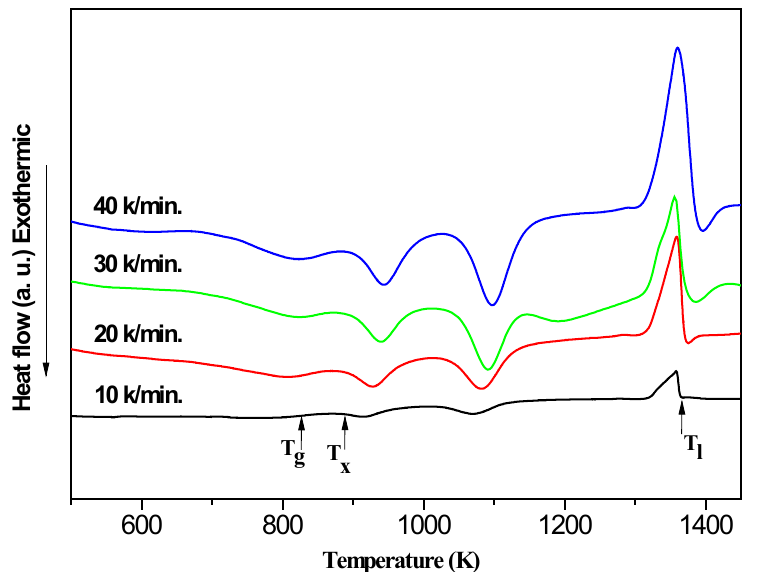
Figure 4. DSC curves of the Al-Ni amorphous alloy at the heating rates of 10, 20, 30 and 40 K/min. Table 2. The thermal pro perties and ΔT x , T rg , γ, γ m of Al-Ni measured at 10, 20, 30 and 40 K/min heating rates.